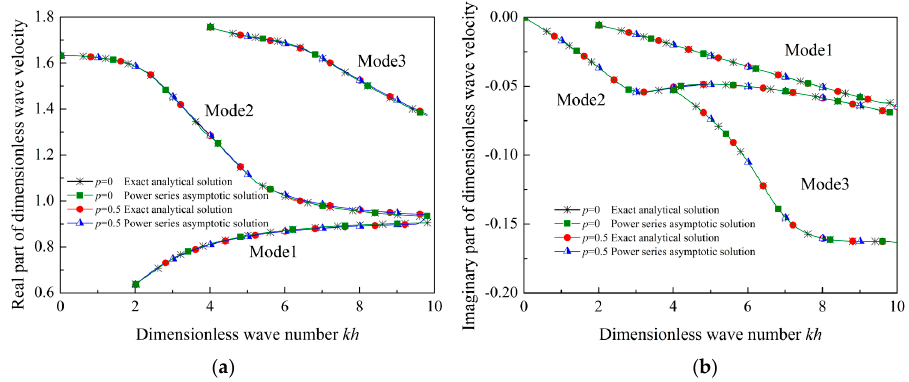
Figure 3. Wave velocity of Lamb waves in homogenous viscoelastic film and in special FGVM film. ( a ) Real part, ( b ) imaginary part.